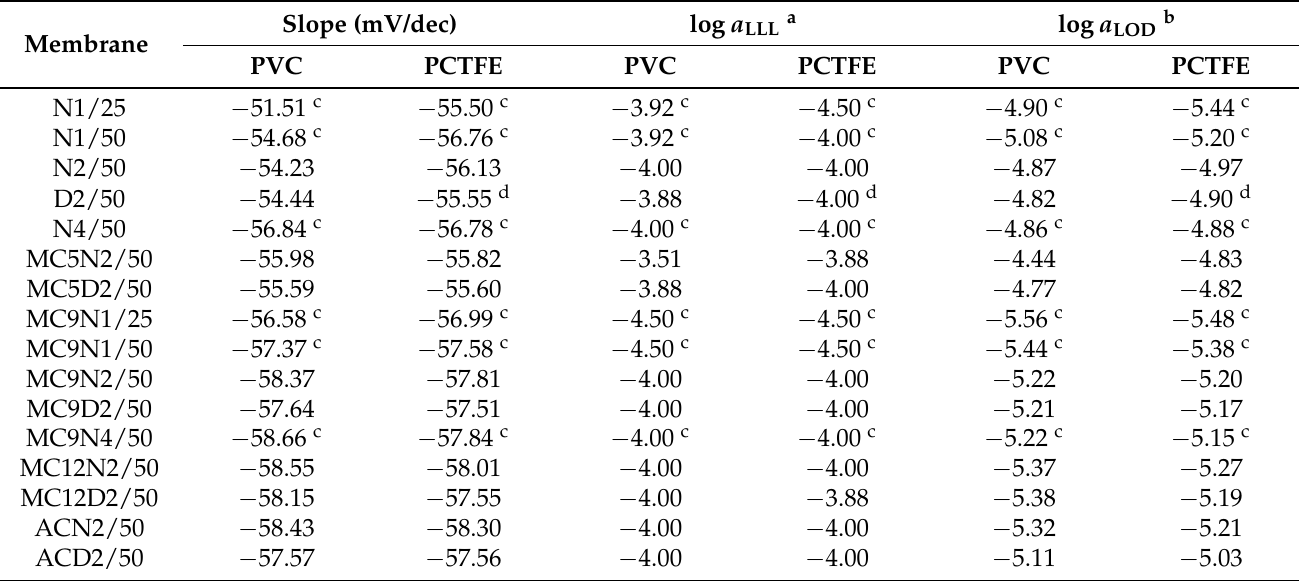
Table A5. Averages of the response characteristics determined from potentiometric calibrations. All linear regressions had an R 2 0.999. The number of measurements and the number of sensors were n = 2 and k = 2, respectively, unless noted ≥ otherwise. See Table A6 for standard deviations. See Table 1 for membrane compositions.